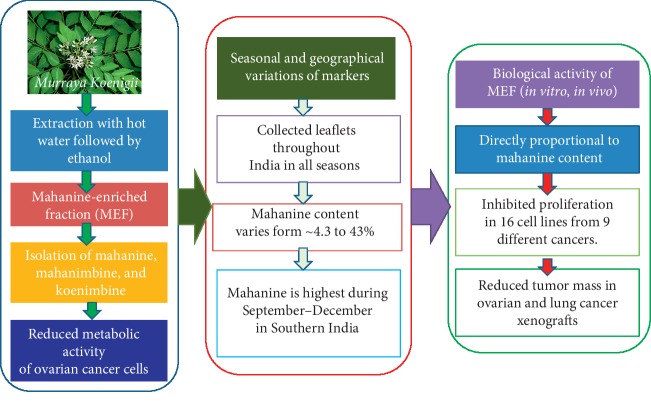
Summary of the study. This figure shows the workflow and conclusions of the study. These data were derived from three individual experiments, and mean ± SD was indicated. ∗The significant difference of p < 0.05.